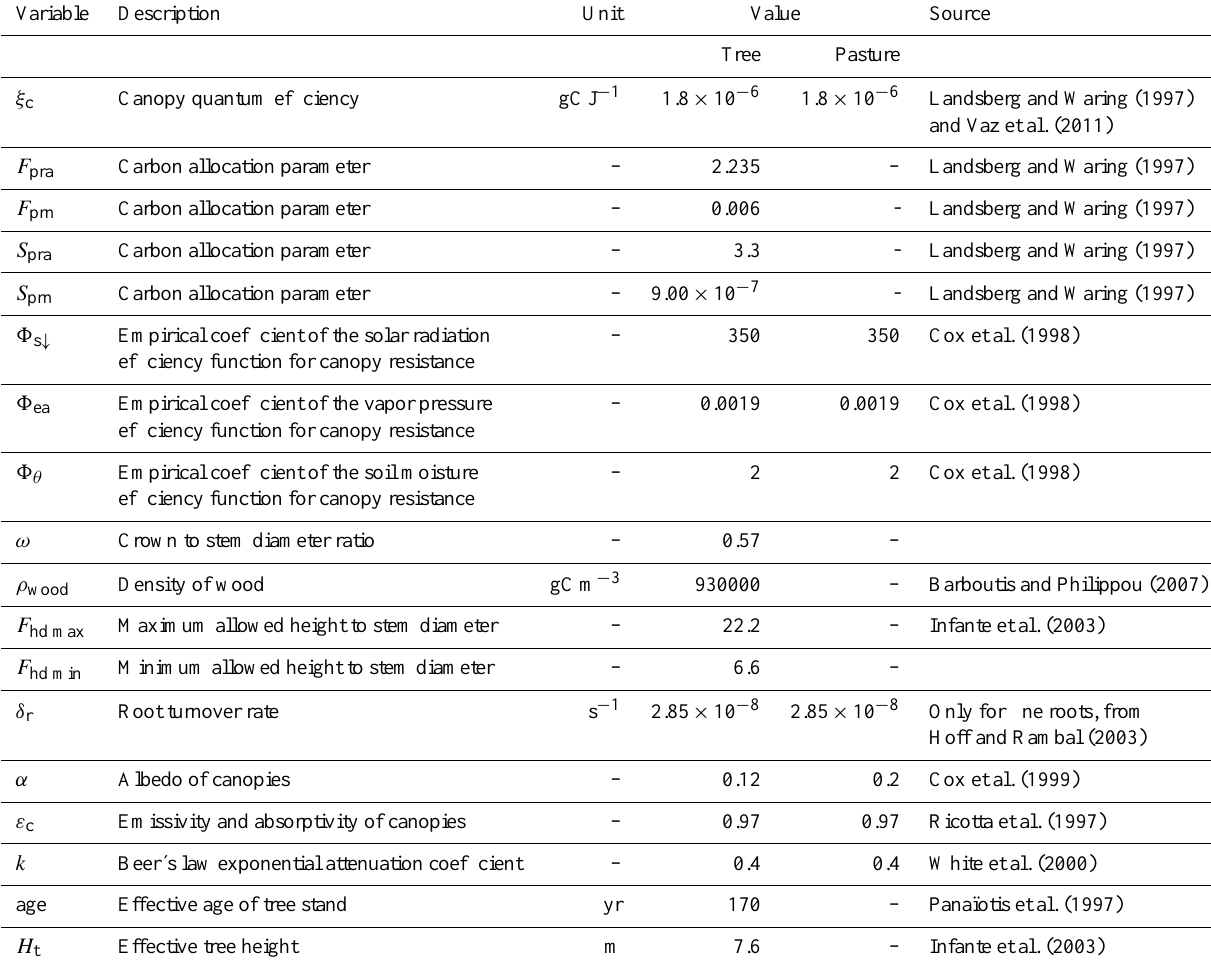
Table 1. List of vegetation parameters used in this study. Variable symbols match those in Maneta and Silverman (2013). Variable